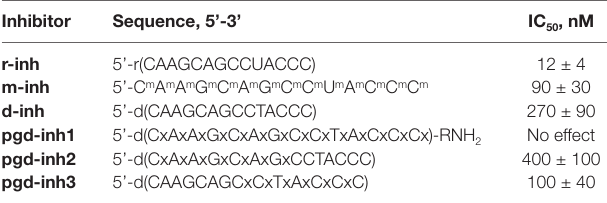
TABLE 1 | The inhibiting oligonucleotides and IC 50 values for hydrolysis of RNA target. Inhibitor